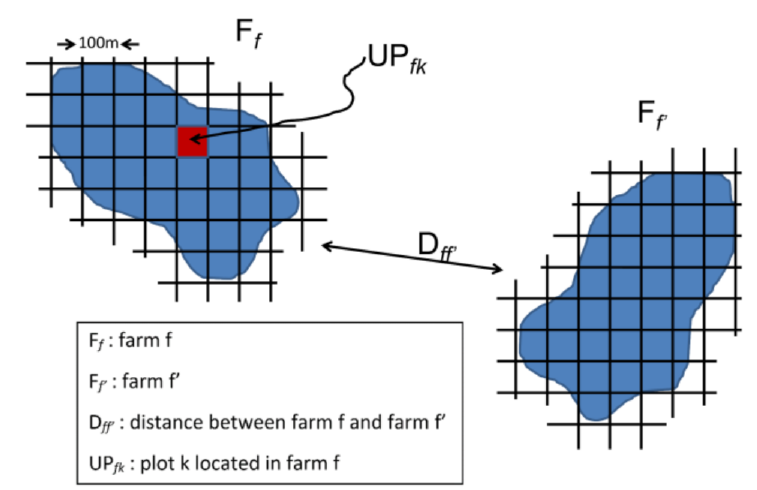
Figure 1. Geographic distribution of two farms ( F f ) and their plots ( UP fk ), with the notation used in the models.